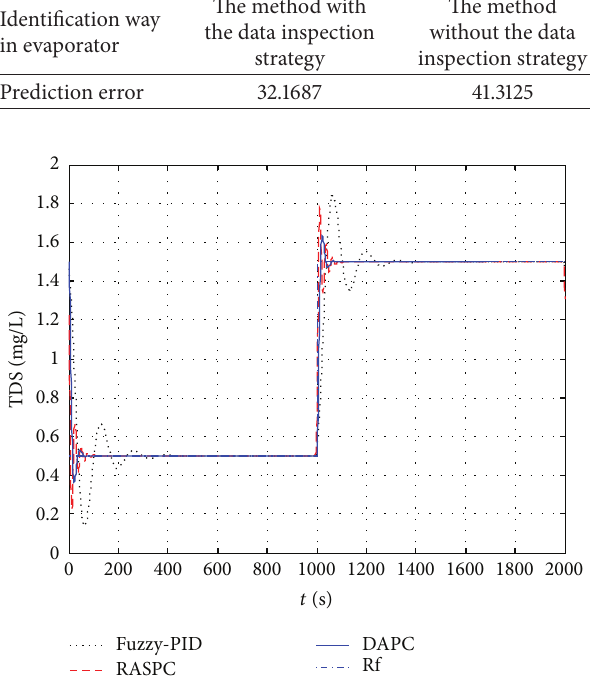
Figure 5: The tracking comparison of output